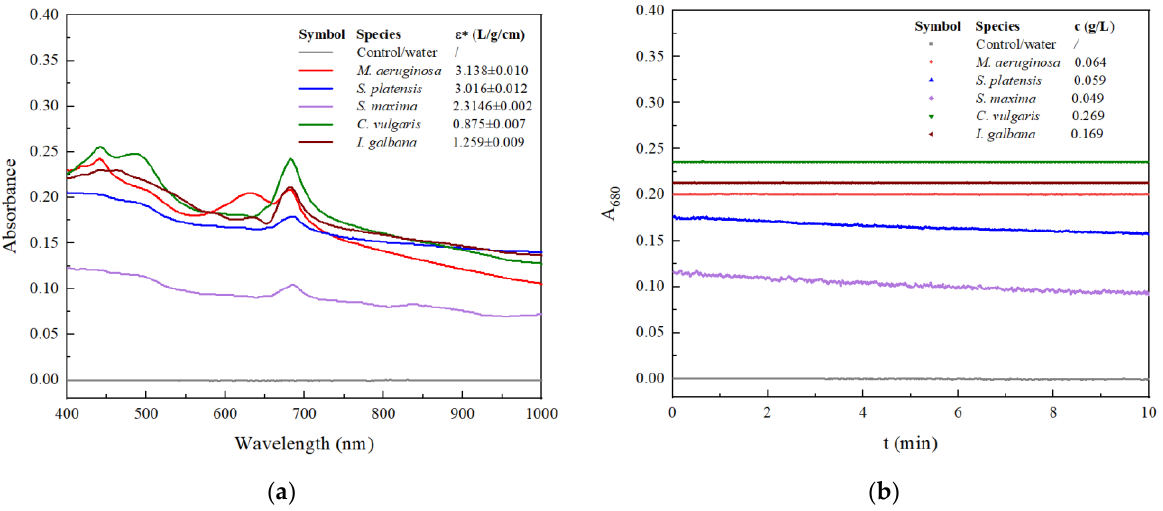
Figure 1. Visible absorption spectra and output data stability for different microalgae species: ( a ) Visible spectra; ( b ) Stability of A 680. * ε values were reported as the mean ± standard deviation of duplicate independent experiments.